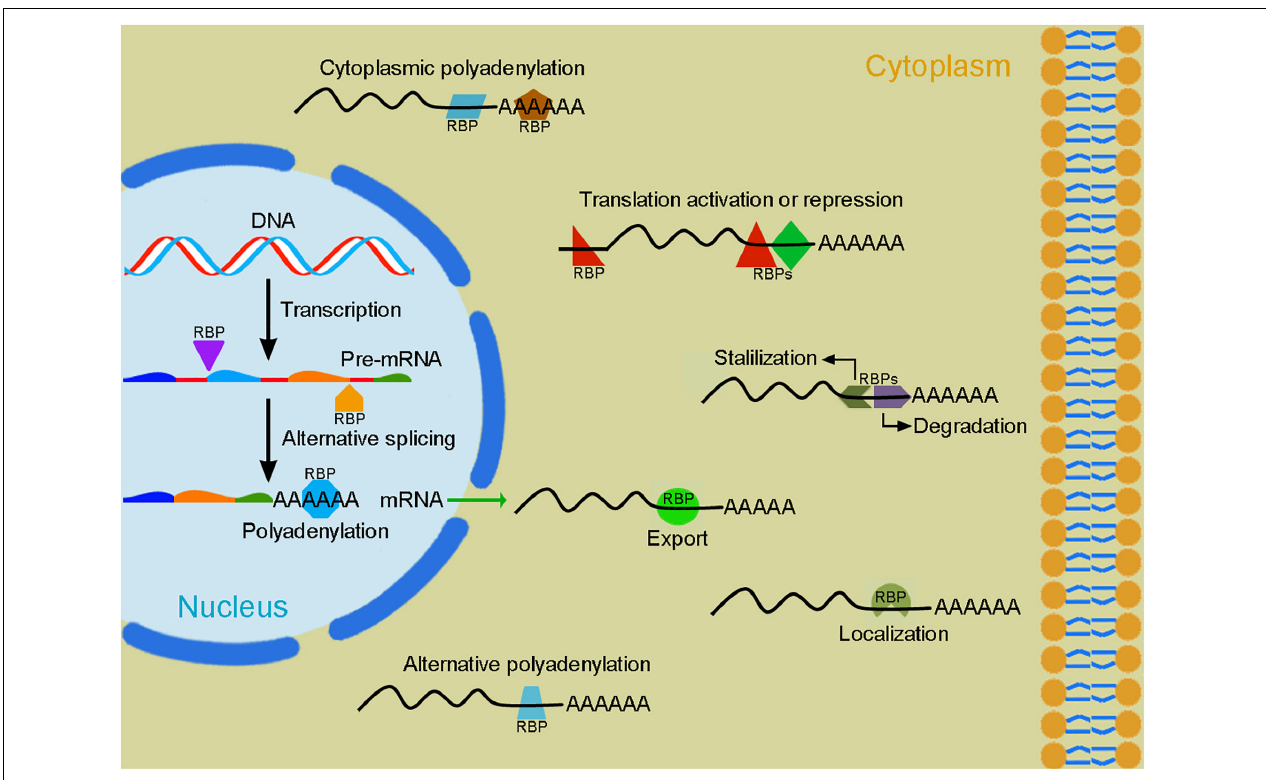
FIGURE 2 | Post-transcriptional regulation of gene expression by RBPs. Following transcription, the dynamic interactions of RBPs (colored forms) with pre-mRNAs or mRNAs in the nucleus and in the cytoplasm regulate their alternative splicing, polyadenylation, export, localization, stability/degradation, and translation. These processes involve a large number of RBPs that function either cooperatively or antagonistically to produce tissue-specific protein isoforms and determine protein levels within a